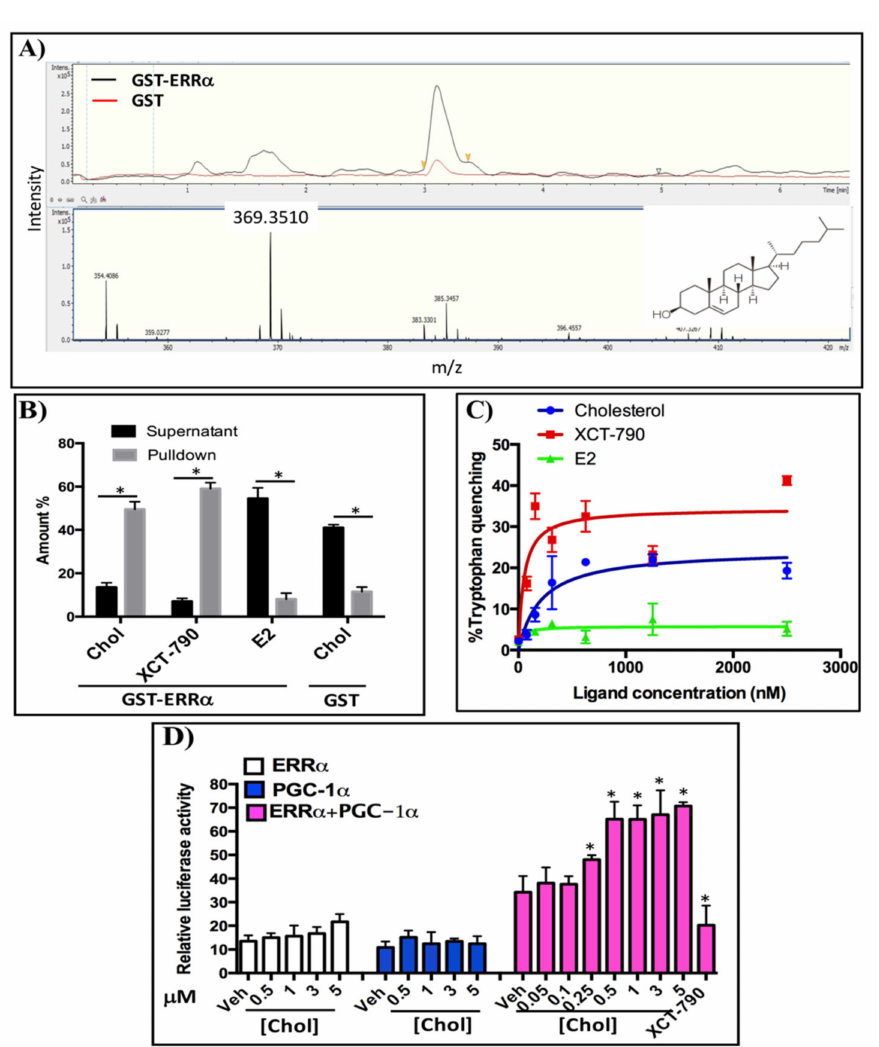
Figure 1. Cholesterol binds to ERR α and increases its activity: ( A ) Human pregnancy serum was incubated with Sepharose beads coupled to GST-ERR α -LBD and or unfused GST for 24 h at 4 ◦ C and pull-down samples were analyzed using LC-MS. The upper panel shows the UV chromatogram and the lower panel displays the mass spectrum. The cholesterol structure is located at the right corner of this spectrum. ( B ) Cholesterol directly binds to ERR α -LBD. GST-ERR α -LBD pull down assays were performed and cholesterol concentrations were measured using LC-MS in MRM mode. XCT-790 and E2 concentrations were determined using a UV–vis spectrophotometer. Amounts are reported as % input. ( C ) Relative a ffi nity of cholesterol for ERR α was assessed using a tryptophan quenching assay with fluorescence excitation at 295 nm and florescent emission at 310 nm. ( D ) Cholesterol increases transcriptional activity of ERR α in a PGC-1 α dependent manner in a luciferase reporter assay. HEK 293 cells were transiently co-transfected with a pS2-LUC reporter plasmid with or without expression vectors for ERR α and the PGC-1 α co-activator. The data are representative of 3 independent experiments. A value of p < 0.05 compared with the control group was considered significant